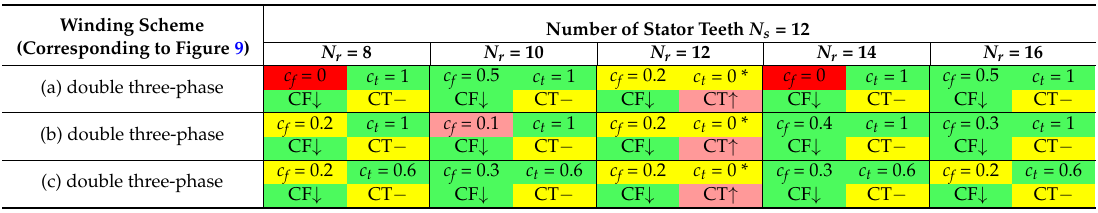
Table 1. Performance factors of different bearingless flux-switching motors, featuring twelve stator teeth and a double three-phase winding system.